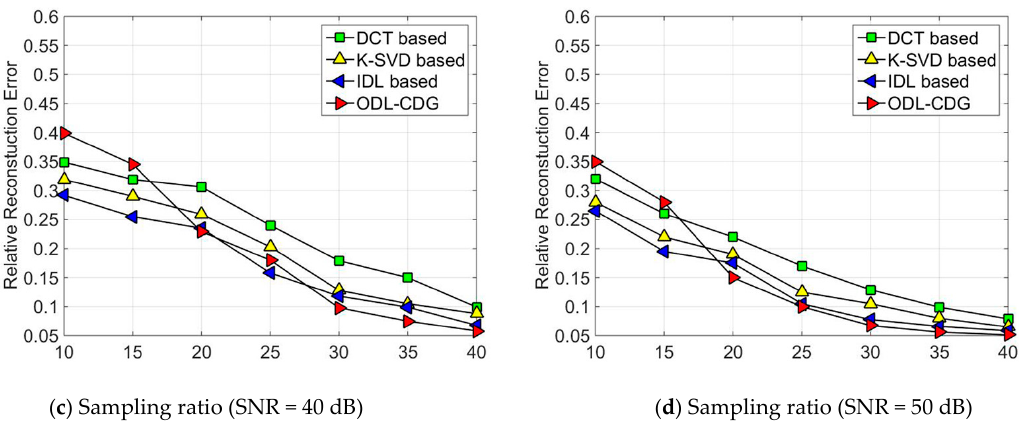
( c ) Sampling ratio (SNR = 40 dB) ( d ) Sampling ratio (SNR = 50 dB) Figure 2. The relative reconstruction error of DCT, K-SVD, IDL and ODL-CDG under different sampling ratio: ( a ) SNR = 20 dB; ( b ) SNR = 30 dB; ( c ) SNR = 40 dB; ( d ) SNR = 50 dB.